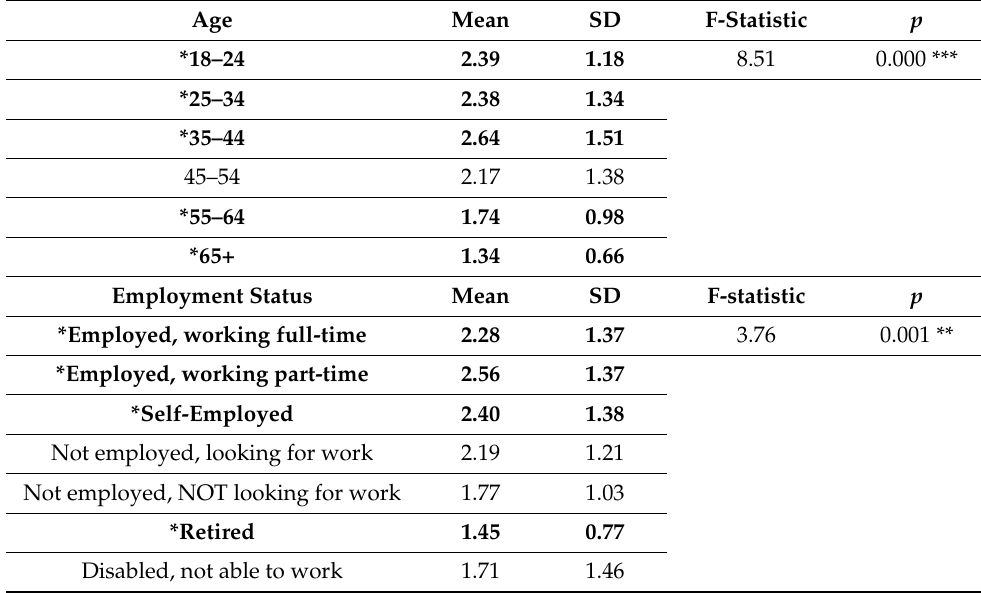
Table 4. Perceived COVID-19 vaccine pressure by age and employment status.